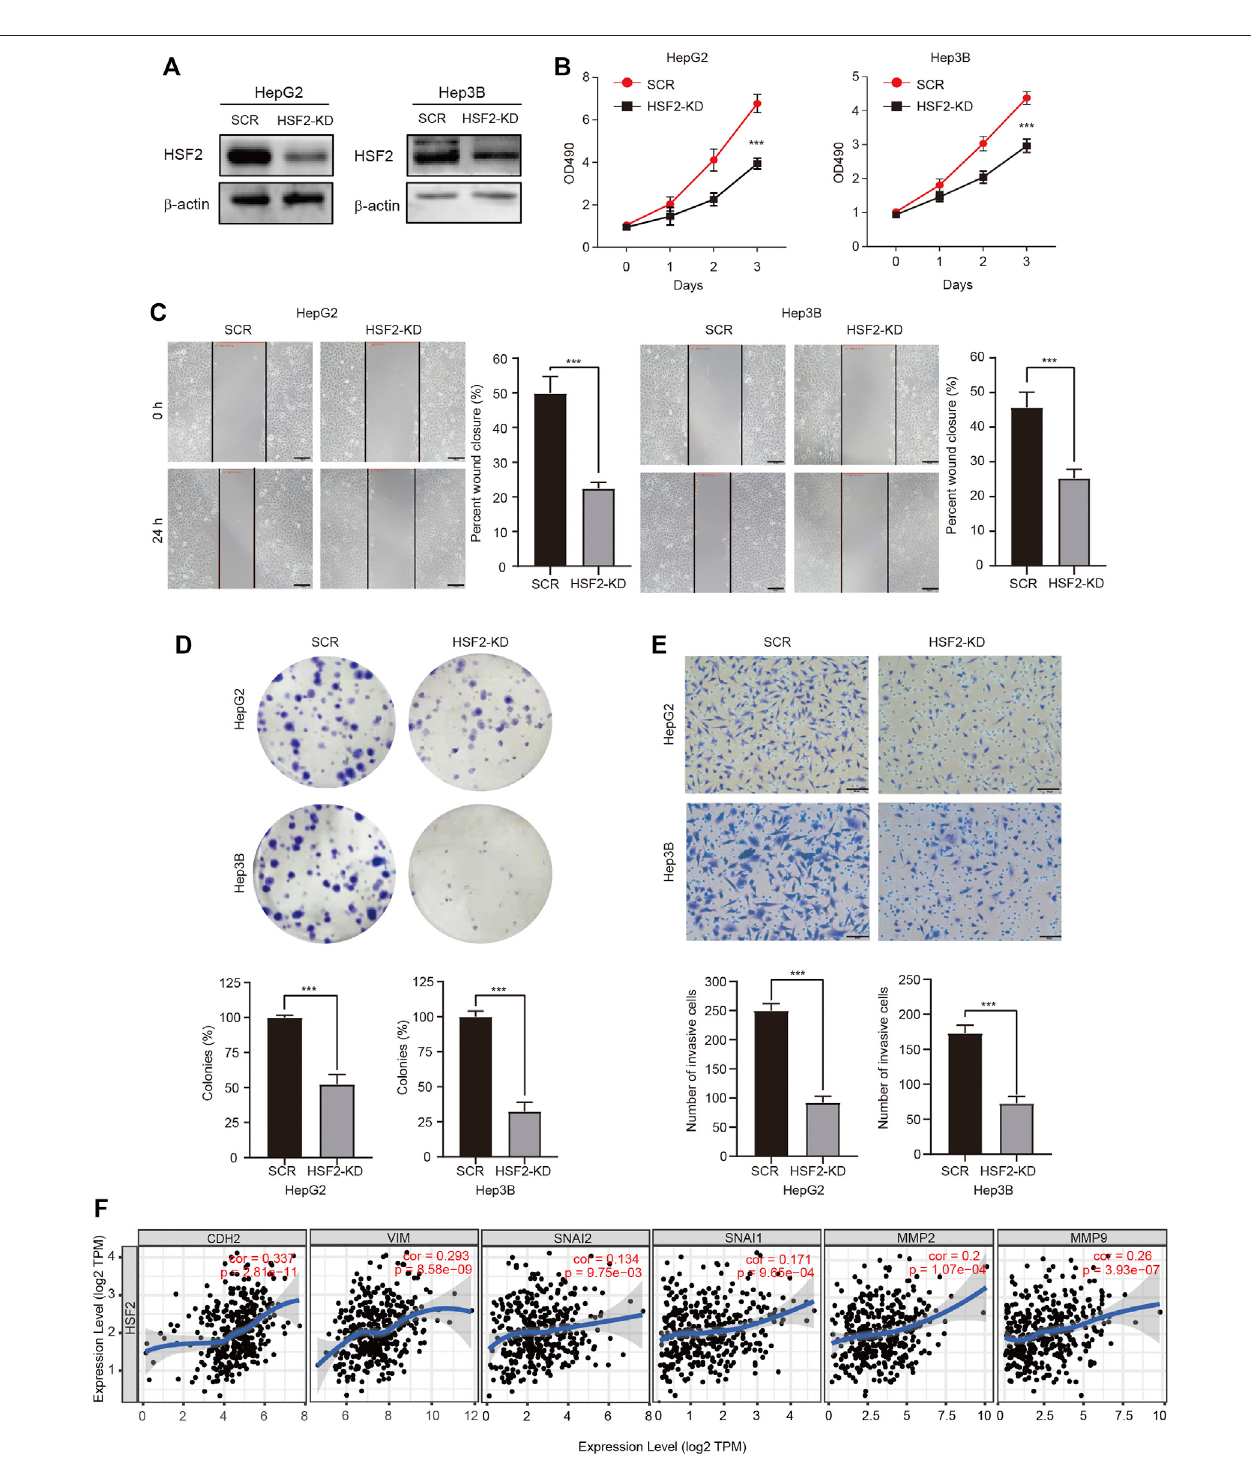
FIGURE 9 | HSF2 mediates the proliferation and malignancy of HCC cells. (A) The knockdown ef fi cacy was con fi rmed by western blotting. (B) Cell viability was examinedusingaCCK-8assay. (C) ThemigrationofHepG2andHep3Bcellswasdetectedusingawoundhealingassay.Scalebar,100 μ m. (D) Representativeimages of colonies formed by HepG2 and Hep3B cells. (E) The invasive ability of HepG2 and Hep3B cells with HSF2 knockdown was detected by performing Matrigel-coated Transwellassay.Numbersofinvadedcellswerecounted.Scalebar,100 μ m. (F) ScatterplotsshowingthecorrelationsofHSF2expressionandCDH2,VIM,SNAI1, SNAI2, MMP2 and MMP9 in HCC using the GEPIA2 database. Data are presented as the means ± SD. * p < 0.05, ** p < 0.01, *** p < 0.01.